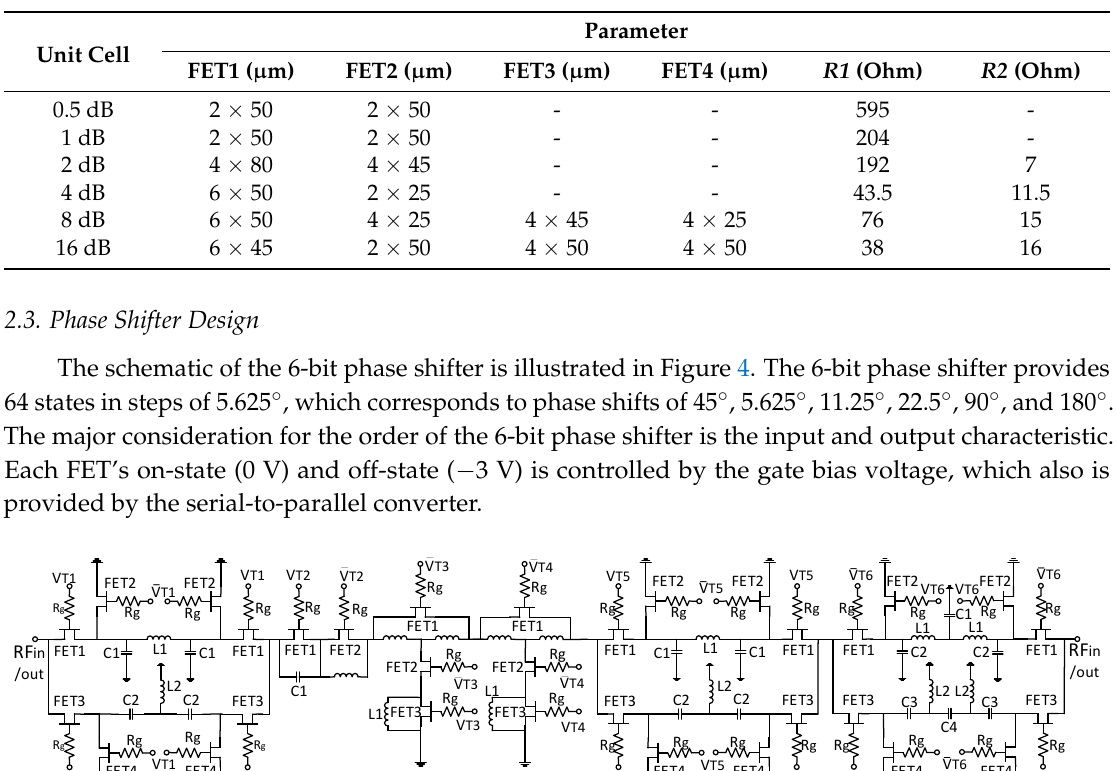
Table 2. The parameters of attenuator design.